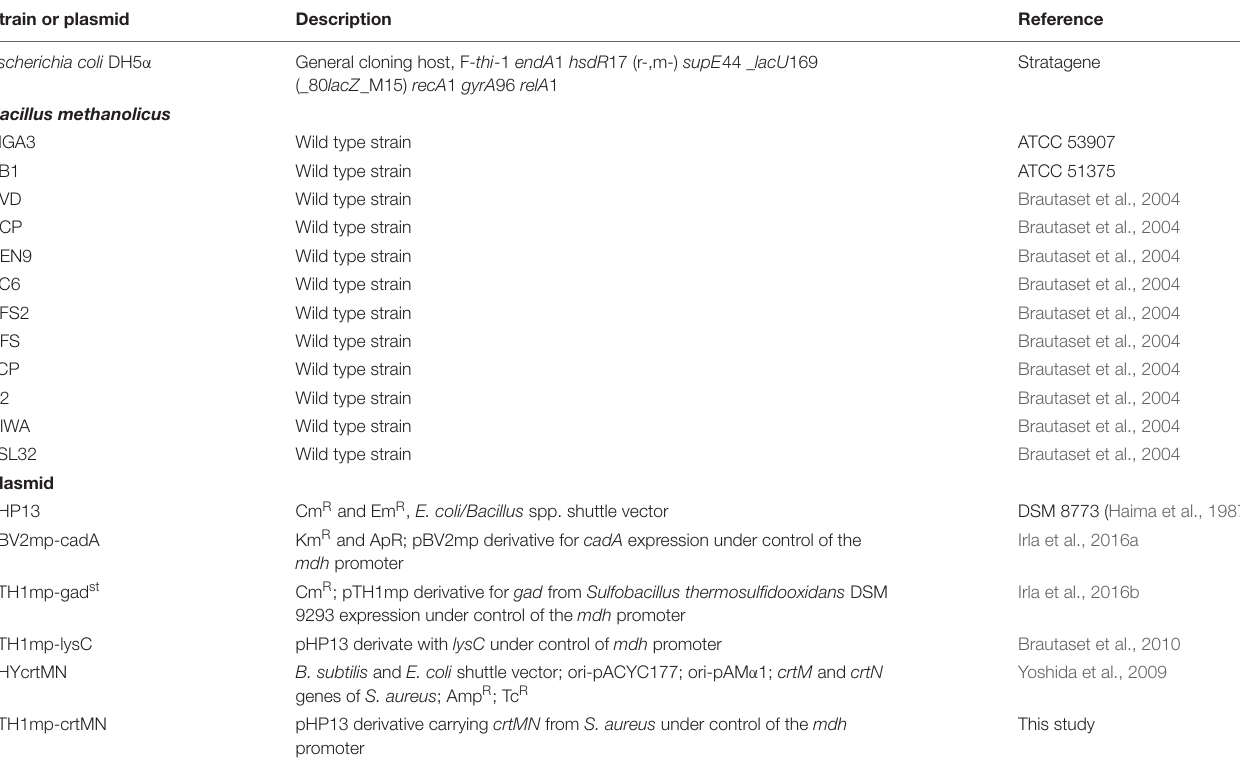
TABLE 2 | Bacterial strains and plasmids used in this